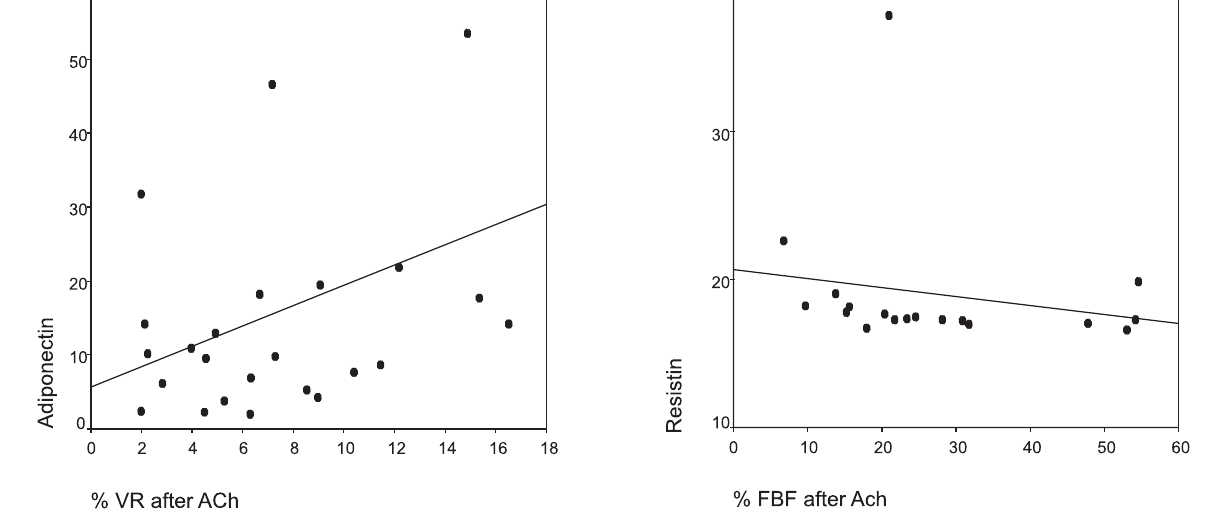
Figure 3 - Relationship between vascular resistance decrement (%) after Ach and adiponectin level in the pooled group